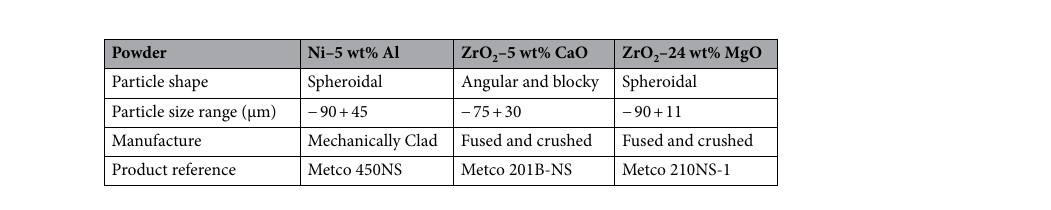
Table 2. Characteristics of powders.